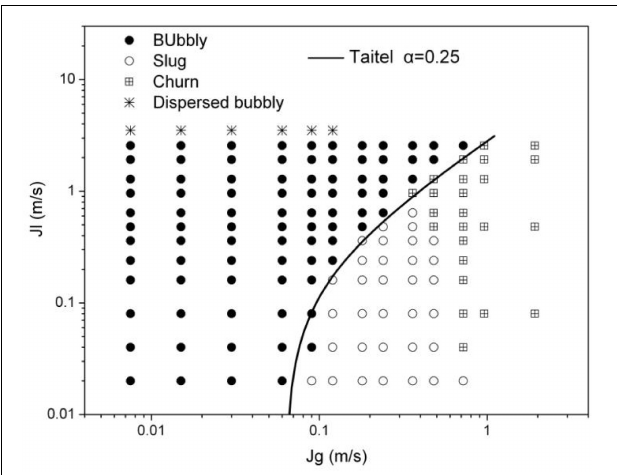
FIGURE 9 | Comparison between Taitel criterion and experimental results.